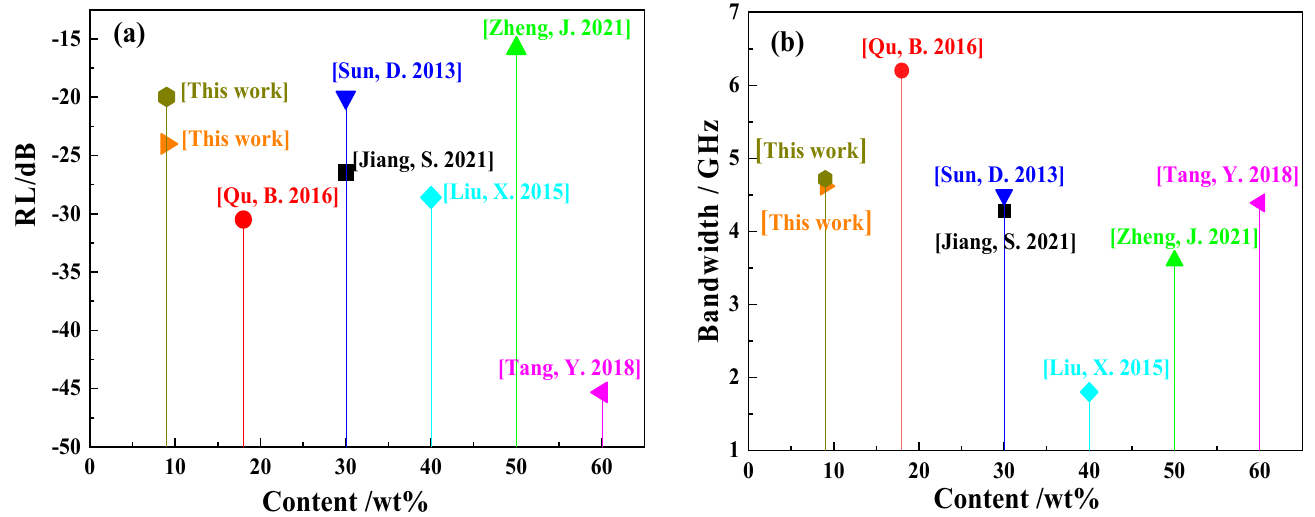
Figure 8. The microwave absorption effects of ( a ) RL and ( b ) bandwidth on the content of some previously reported Fe 3 O 4 foamed composites [12,24,26,37–39]. Table 1. The microwave absorption effects of some previously reported Fe 3 O 4 foamed composites.